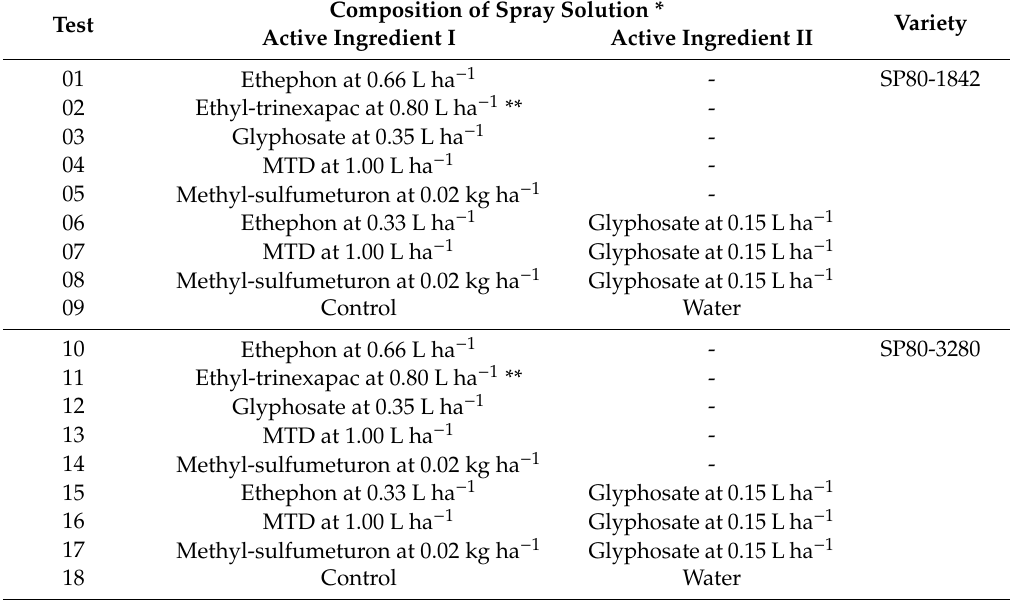
Table 2. Experimental tests planned for the investigation of technical viability of the chemical ripening agents as low-cost strategies to enhance enzymatic antioxidant system of sugarcane